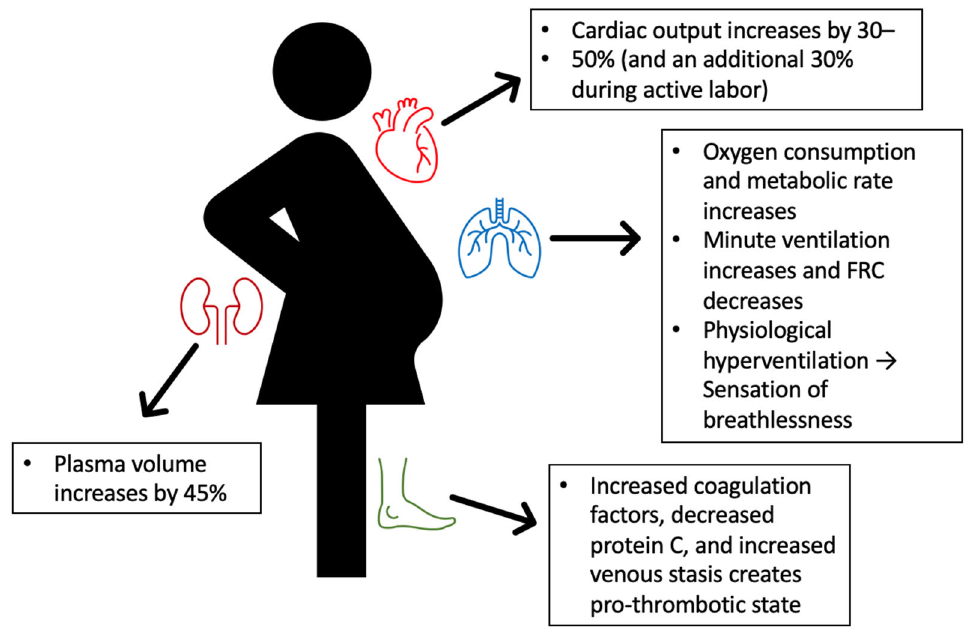
Figure 2. Physiological changes during